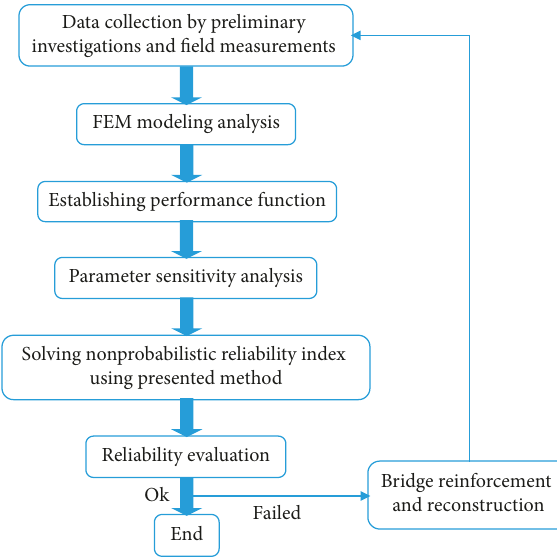
Figure 1: Reliability evaluation